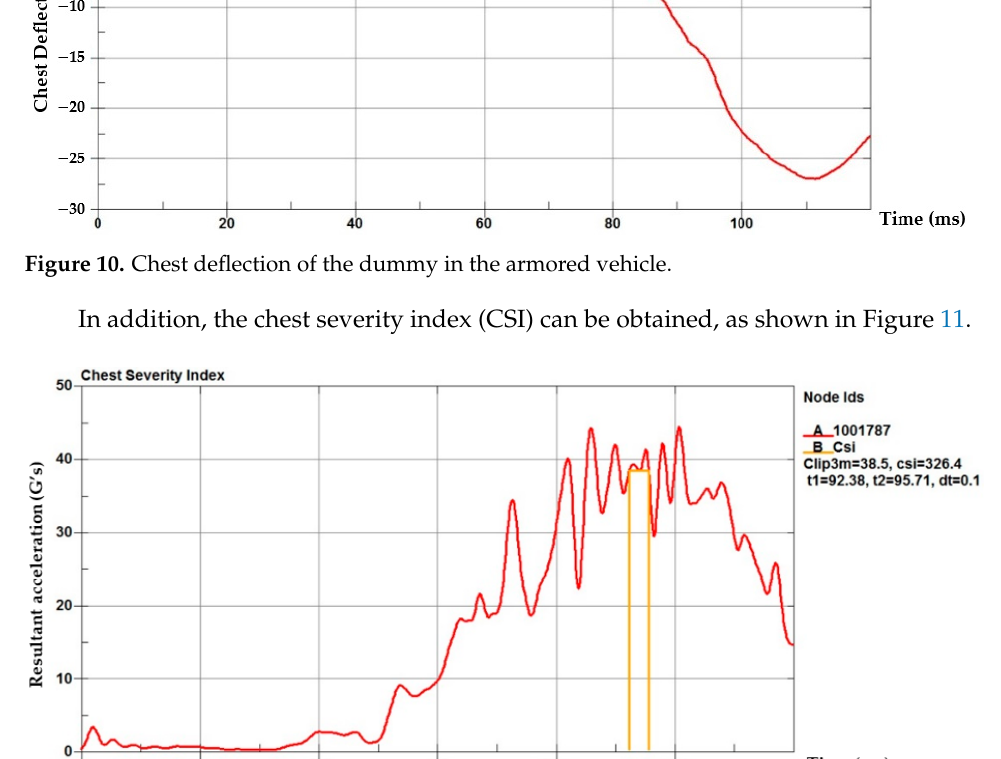
Figure 11. Chest severity index of the dummy in the armored vehicle.